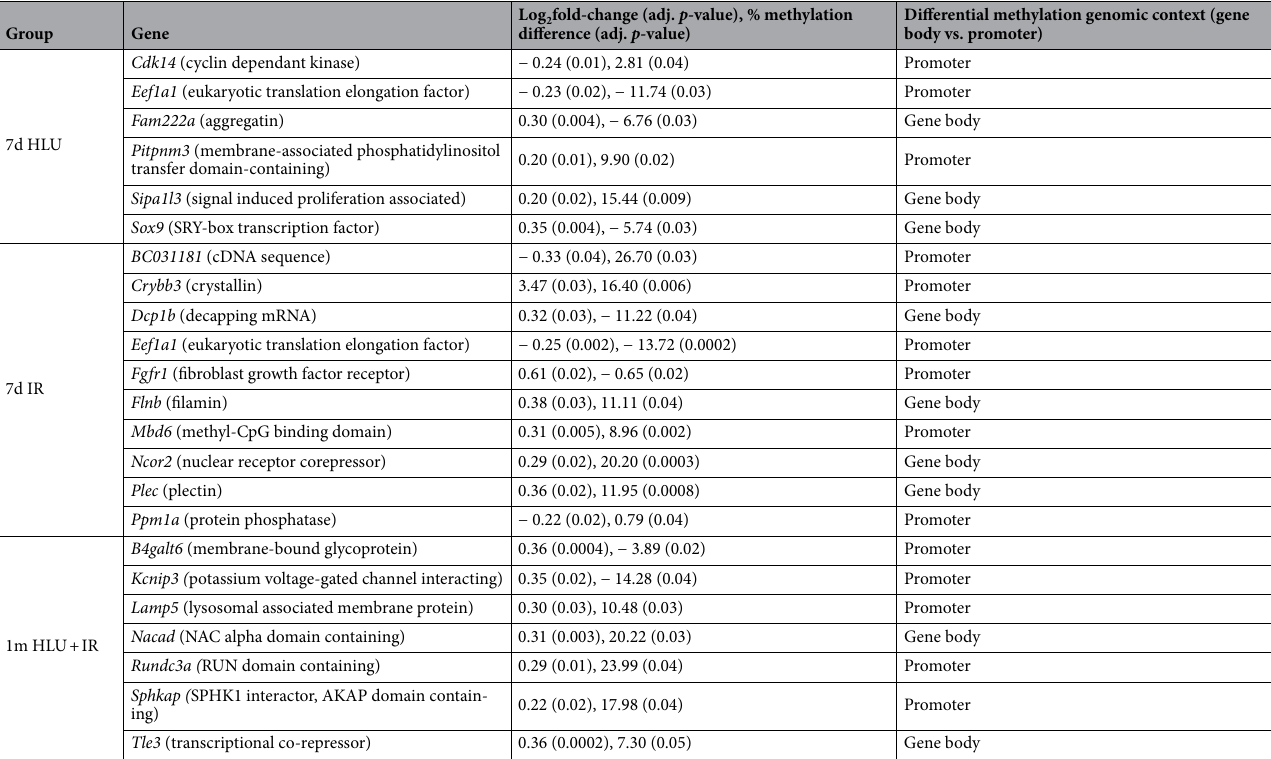
Table 3. Genes with statistically significant expression and methylation changes. Genes that are differentially expressed in a given group (adjusted p -value ≤ 0.05) and also contain at least one differentially methylated locus or region (adjusted p -value ≤ 0.05) are listed. Log 2 (fold-change) for expression difference, percentage methylation difference, and location of DML or DMR within gene context (promoter vs. gene body) are also included. Adjusted p -values for expression and methylation differences are also provided. HLU hindlimb unloading, IR irradiation, DML differentially methylated locus, DMR differentially methylated